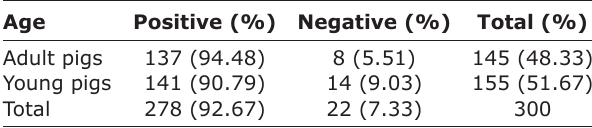
Table-3: Age distribution of Campylobacter isolates in pigs fecal samples from Zuru Kebbi State.